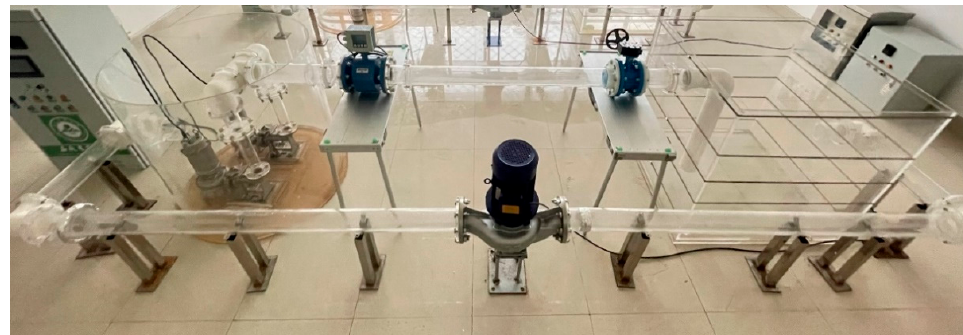
Figure 14. Physical drawing of centrifugal prefabricated pumping station test bench.